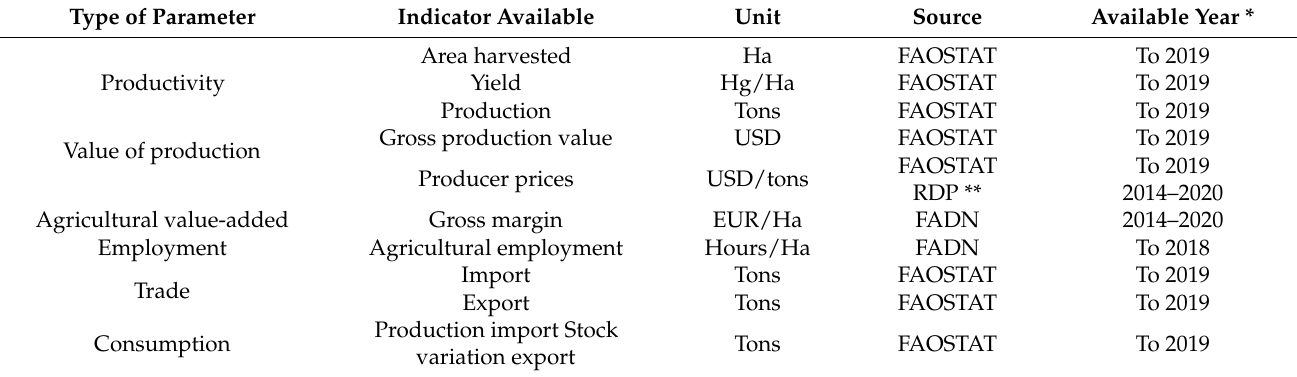
Table A2. Parameters used for the estimation of potential socio-economic impacts of Xylella fastidiosa for the main crops in the European Mediterranean countries, the Balkans, and the Middle East and North Africa